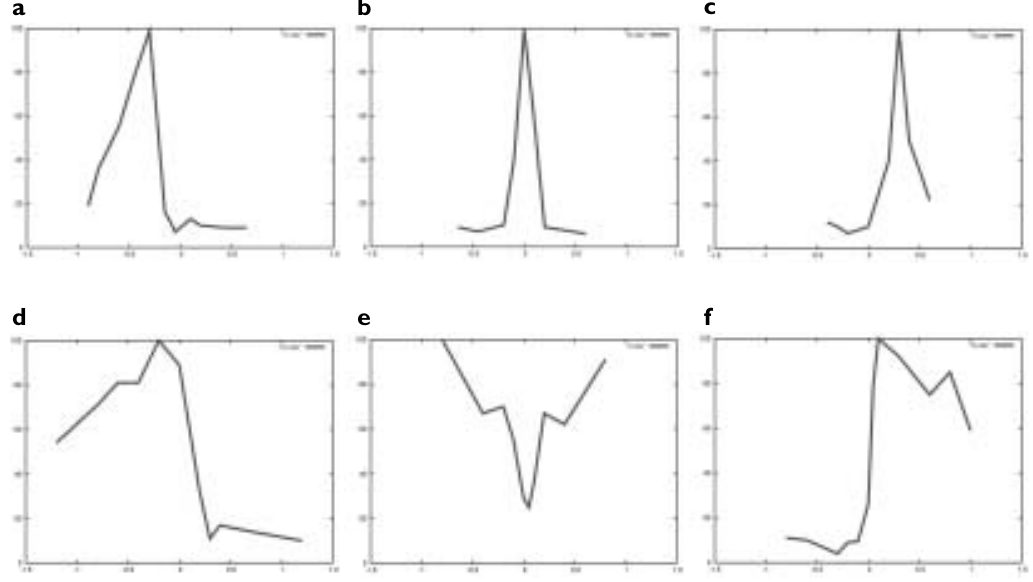
Figure 5 Disparity-detection cells: (a) tuned near (TN); (b) tuned excitatory (TE); (c) tuned far (TF); (d) near (NE); (e) tuned inhibitory (TI); and (f) far